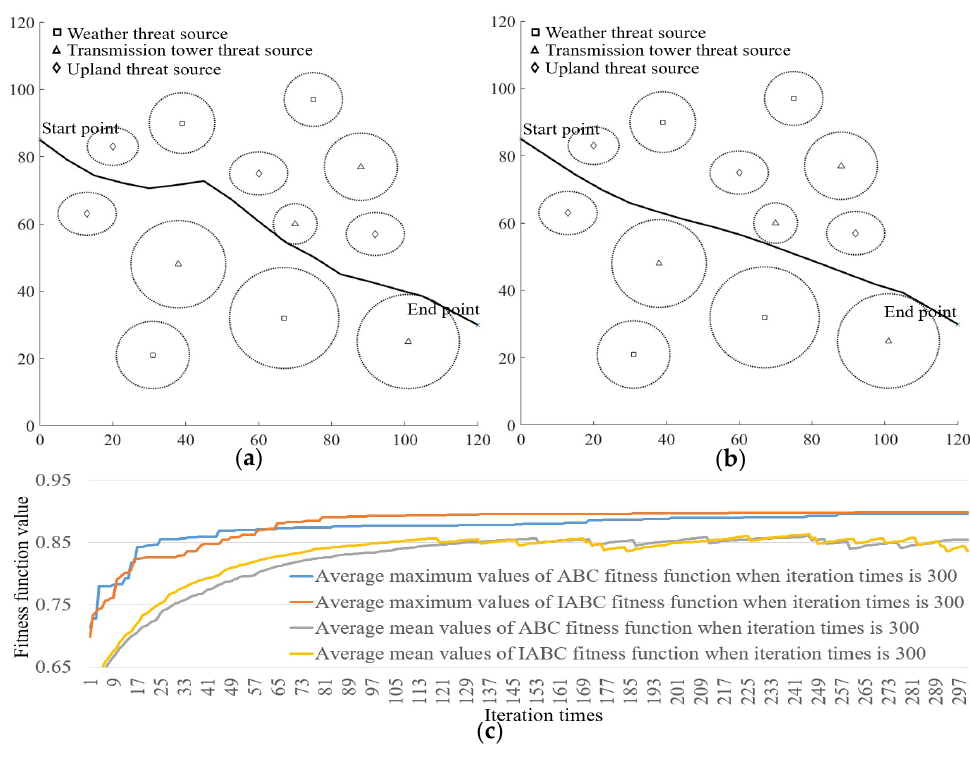
Figure 9. Examples of path planning and statistical results of fitness function using 300 iterations. ( a , b ) Path planning examples of ABC and IABC when iteration times is 300. ( c ) Statistical results of fitness function of ABC and IABC when iteration times is 300.